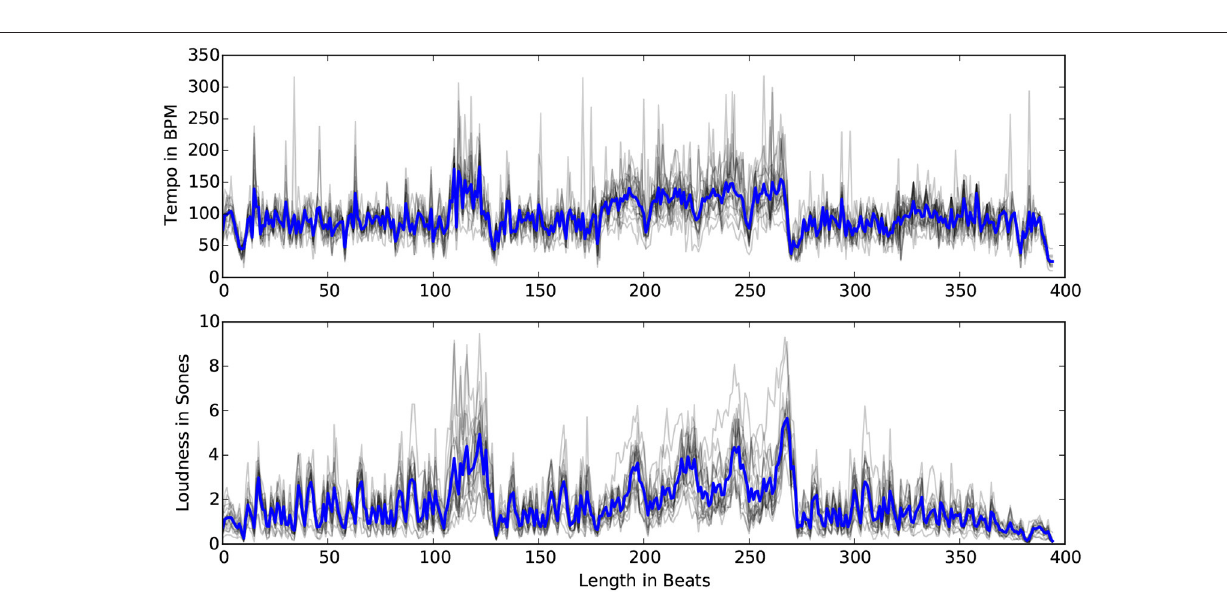
loudness parameters for each participant. The expert players’ practice sessions showed higher variance (longer boxes) in both loudness and tempo as compared to novices. This indicates that they vary these parameters more throughout the practice session. They also play faster than novices, and